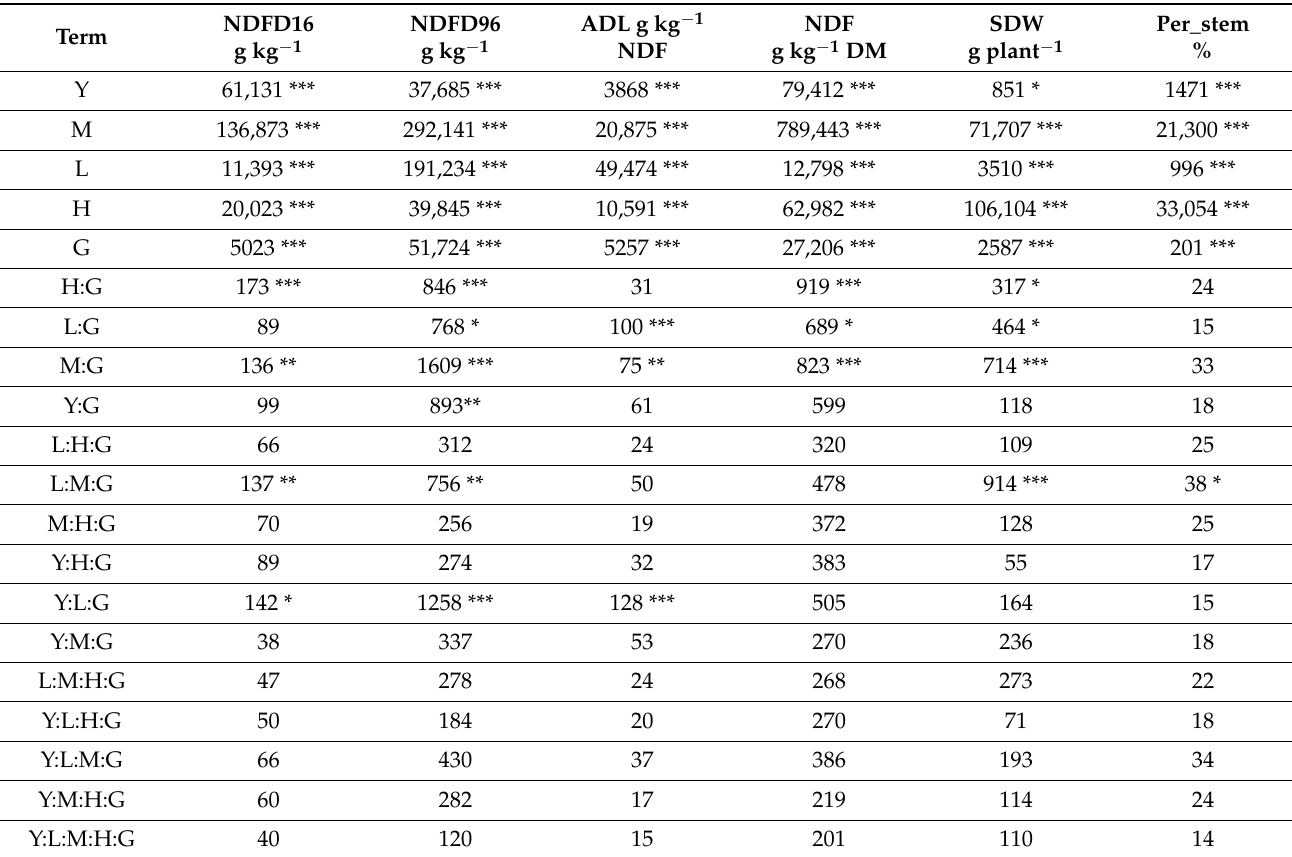
Table 2. Mean squares summary from the analysis of variance (ANOVA) for 16 h IVNDFD (NDFD16), 96 h IVNDFD (NDFD96), acid detergent lignin (ADL) as a proportion of NDF, neutral detergent fiber (NDF), stem dry weight (SDW), and percent stems (Per_stem) among the following five